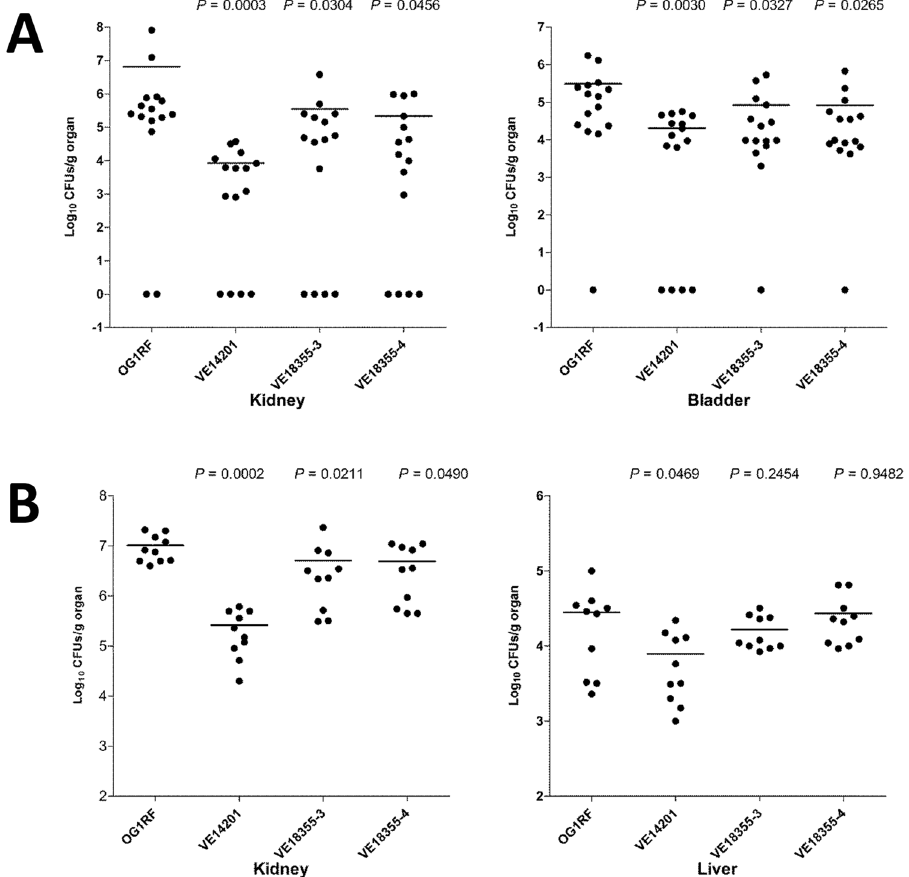
Figure 6. In vivo effect of the FID deletion in ElrA in two mice infection models. ( A ) Groups of 15 BALB/c mice were challenged transurethrally with the OG1RF wild-type, VE14201 Δ elrA , VE18355–3 and VE18355–4 elrA Δ FID strains. Data are expressed as the log 10 colony-forming units (CFUs) recovered per gram of kidneys or urinary bladder homogenates collected 48 hours after the challenge. The log 10 CFUs from both kidneys were combined and averaged. A value of 0 was assigned to the uninfected organs. Horizontal bars represent the geometric means. P values of less than 0.05 were considered to be significant. ( B ) Groups of 10 BALB/c mice were infected with the OG1RF wild-type, VE14201 Δ elrA , VE18355–3 and VE18355–4 elrA Δ FID strains. Data are expressed as the log 10 colony-forming units (CFUs) recovered per gram of kidneys or liver homogenates collected 7 days after the challenge. Horizontal bars represent the geometric means. P values of less than 0.05 were considered to be